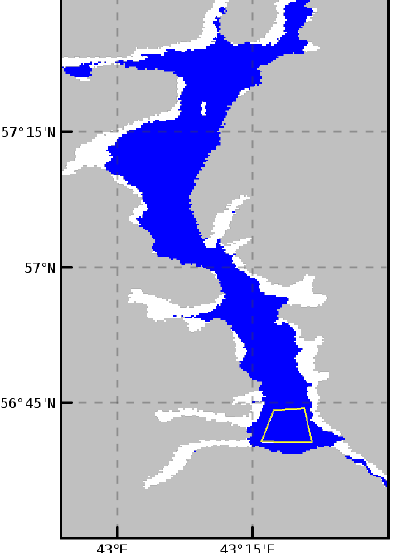
Figure 2. Valid water pixels of the Gorky Reservoir on 31 May 2022 (blue), used to estimate the number of pixels with the CHLFAIL flag. Gray color denotes the land mask, white color, the coastal areas marked with the CLDICE flag due to high radiance values, and the yellow quadrangle is the test polygon for evaluation of AOD and R rs .